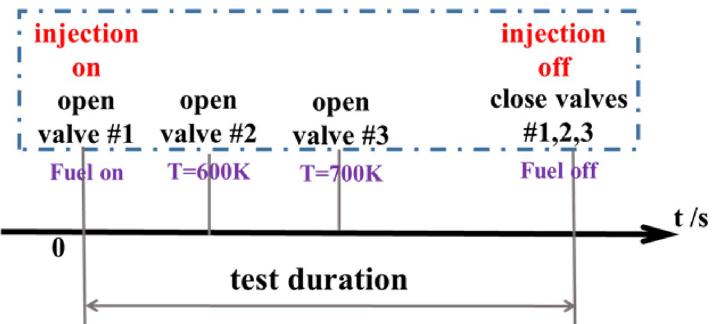
Fig. 8 Procedure of the convective heat transfer